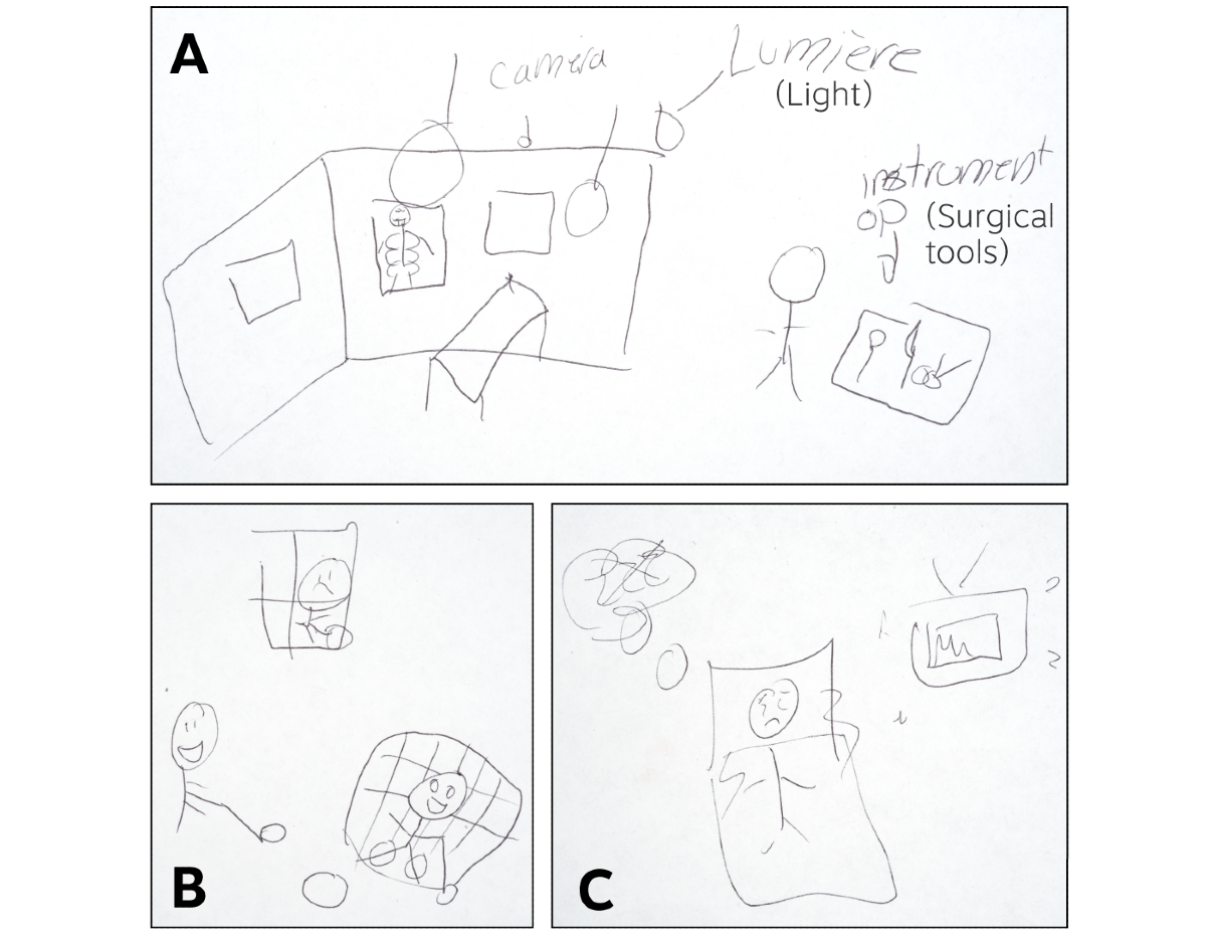
Figure 2. Suggested new symptoms and the corresponding vignettes. A. How is it for you to enter the operating room? Participant #11, 11 years old: “In the room, there are lots of lights. There is a bed and sometimes, you can see the staff looking at their sharp silver instruments and that’s stressful for a child. There are also cameras and radiographic images! Those can be really scary.” B. How do you feel when you are not able to do certain activities? Participant #11, 11 years old: “Show someone in a cast looking out of the window sadly watching their friends play hockey. It affects you to see your friends happy while you have to stay inside doing nothing. That’s it…” C. How is it for you to wake up after a surgery? Participant #11,